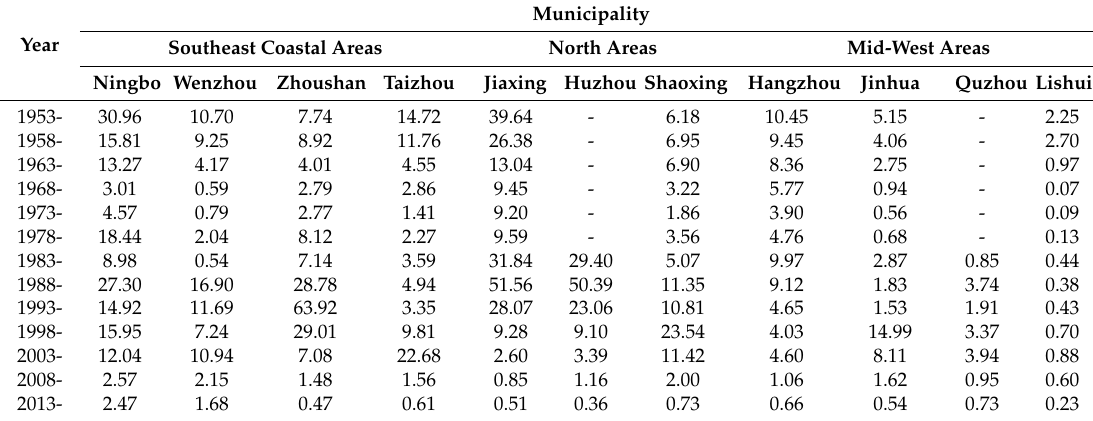
Table 2. The average annual incidence of typhoid and paratyphoid in all municipalities in Zhejiang from 1953 to 2014 (/100,000).